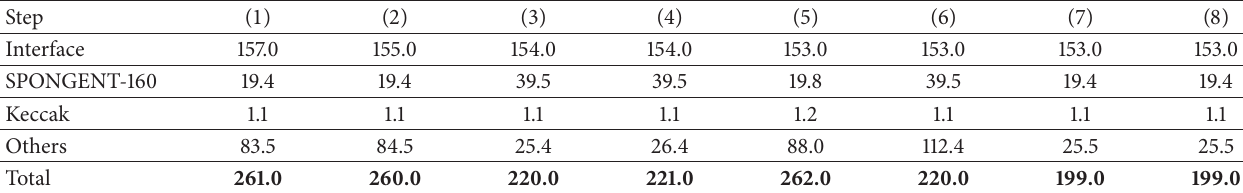
Table 4: Simulated power consumption of the cryptographic block using SPONGENT-160 ( 𝜇 W).